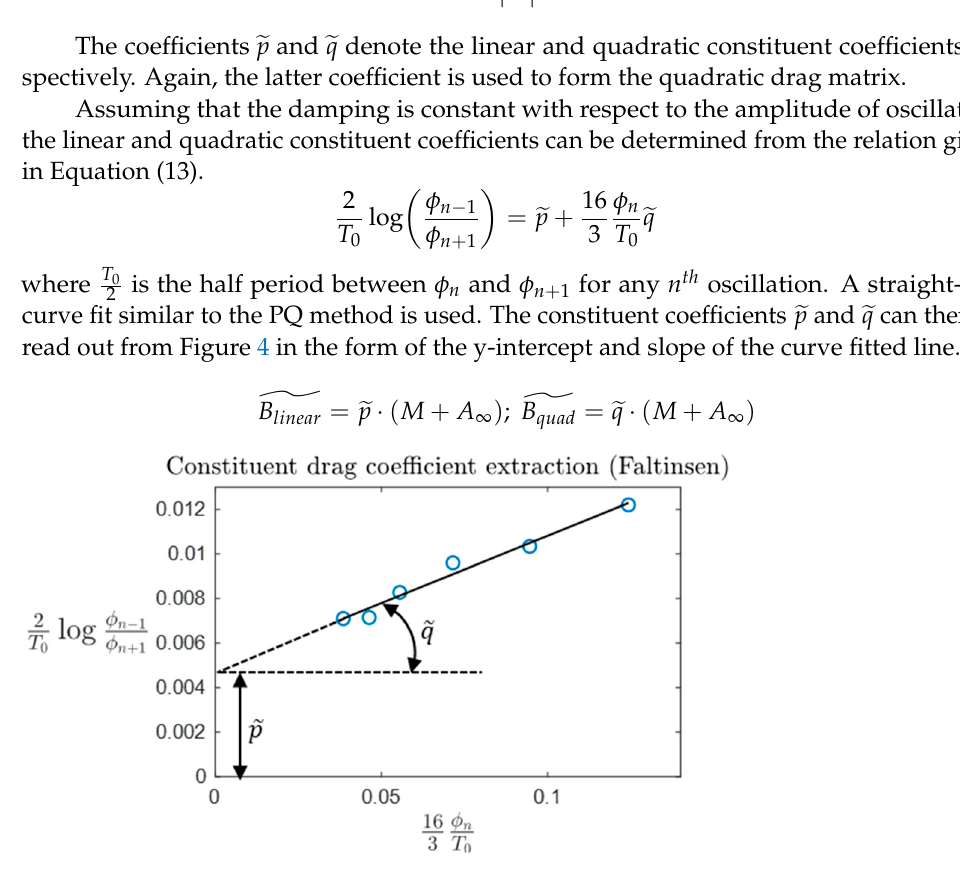
Figure 4. Faltinsen’s constituent coefficient extraction using least-square curve fit of the crest ampli-